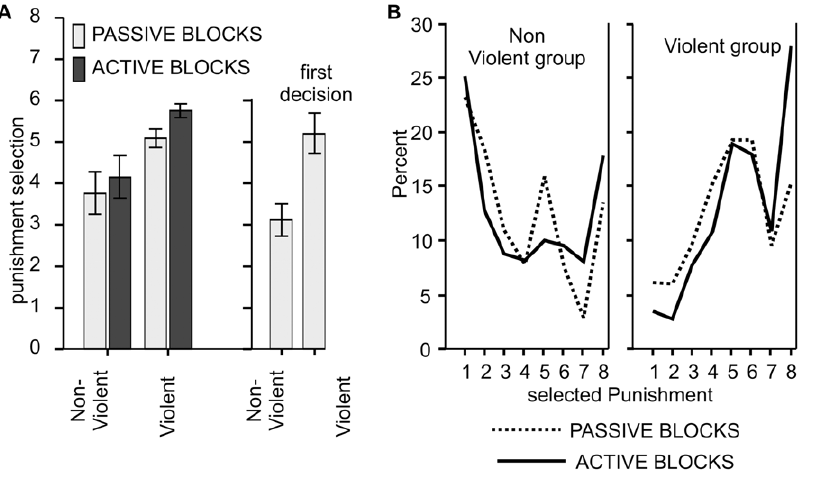
Figure 2. Punishment strengths. a) Mean punishment strengths selected in the decision phase. The rightmost bars of Figure 2a depict the first selection at the beginning of the experiment. b) Percentage of punishment strength 1 to 8 given during the experiment.